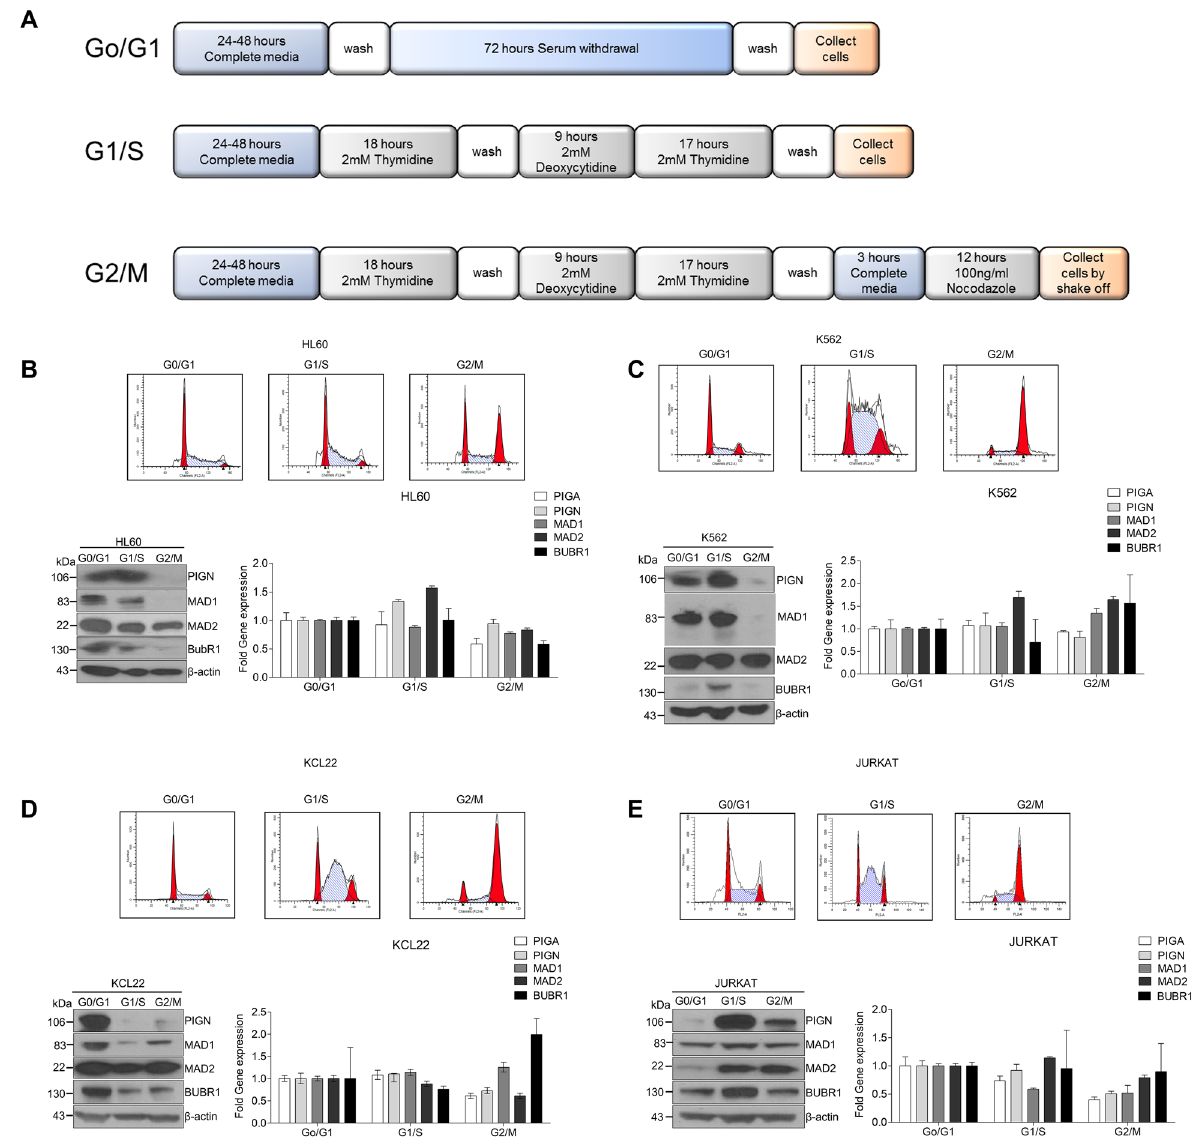
Figure 1. PIGN expression is cell cycle regulated. ( A ) Schematic of cell cycle synchronization protocols. Cell synchronizations were achieved using serum starvation for 72 h (Go/G1), double-thymidine block (G1/S), or double thymidine block and release followed by nocodazole treatment (G2/M). Cells were collected post-treatment for western blotting, RT-qPCR, and flow cytometry analyses. PIGN was expressed in a cell cycle-dependent manner in multiple cell lines: ( B ) HL60, ( C ) K562, ( D ) KCL22, and ( E ) JURKAT with suppressed expression from early S-phase to the G2/M phase. All western blot images were cut within the molecular weight ranges of the protein targets prior to hybridization. Images generated from these cut blots by scanning the developed films. Images were cropped and labeled using Adobe Photoshop CC 2017